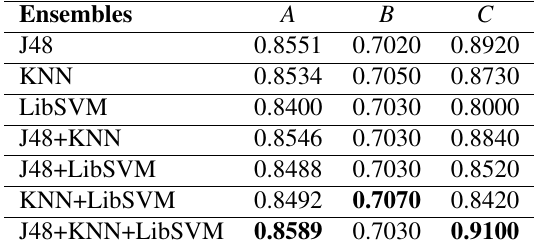
Table 5. The training results with DATASET3 .